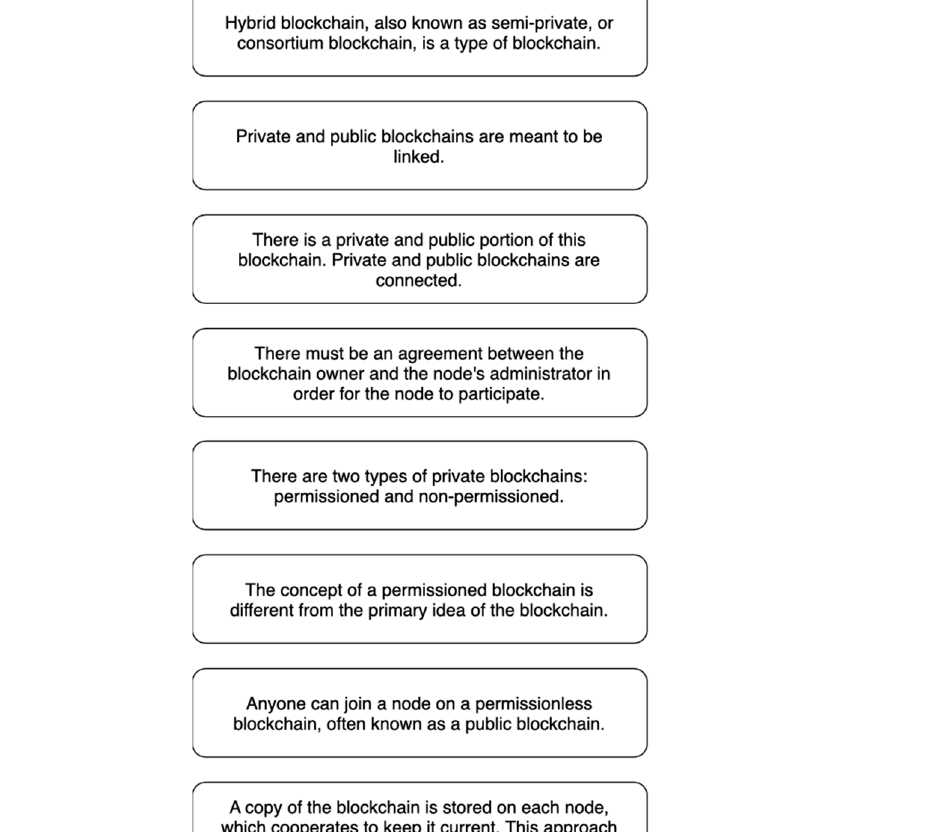
Figure 6. Types of Nodes.